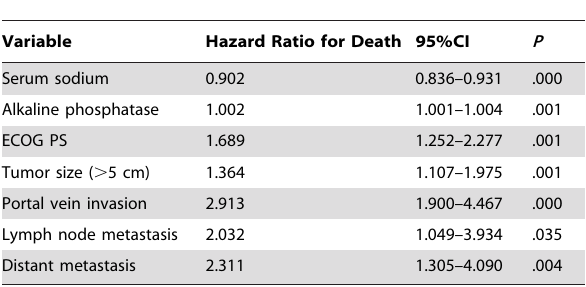
Table 3. Independent prognostic factors for overall survival in the 196 patients with unresectalbe HCC according to univariate and multivariate